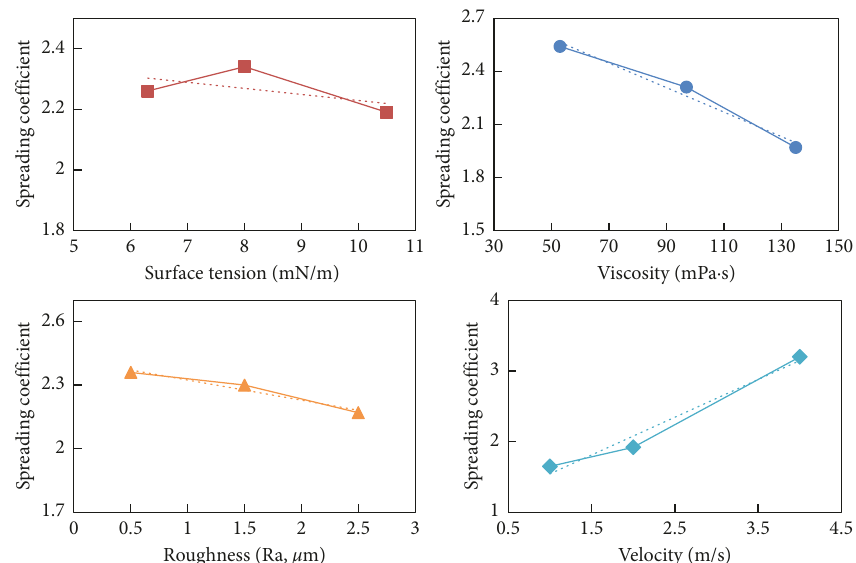
Figure 6: Relationships between marginal means and factors influencing the spreading